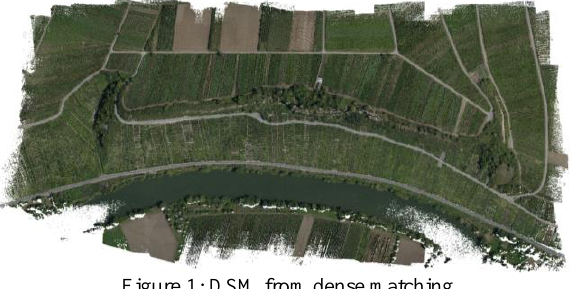
Figure 1: DSM from dense